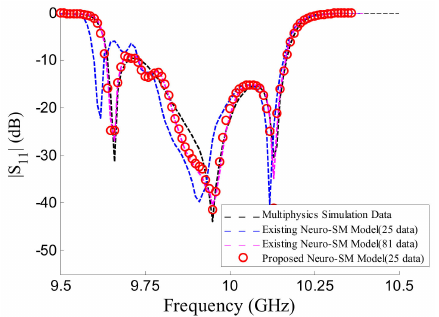
Figure 6. S 11 (in decibels) comparison between the multiphysics simulation data, ANN model (81 data), existing Neuro-SM model (81 data), and proposed Neuro-SM model (25 data) when the test sample is x = [ 4.945,7.002,7.315,47.5 ] T for the iris coupled microwave cavity